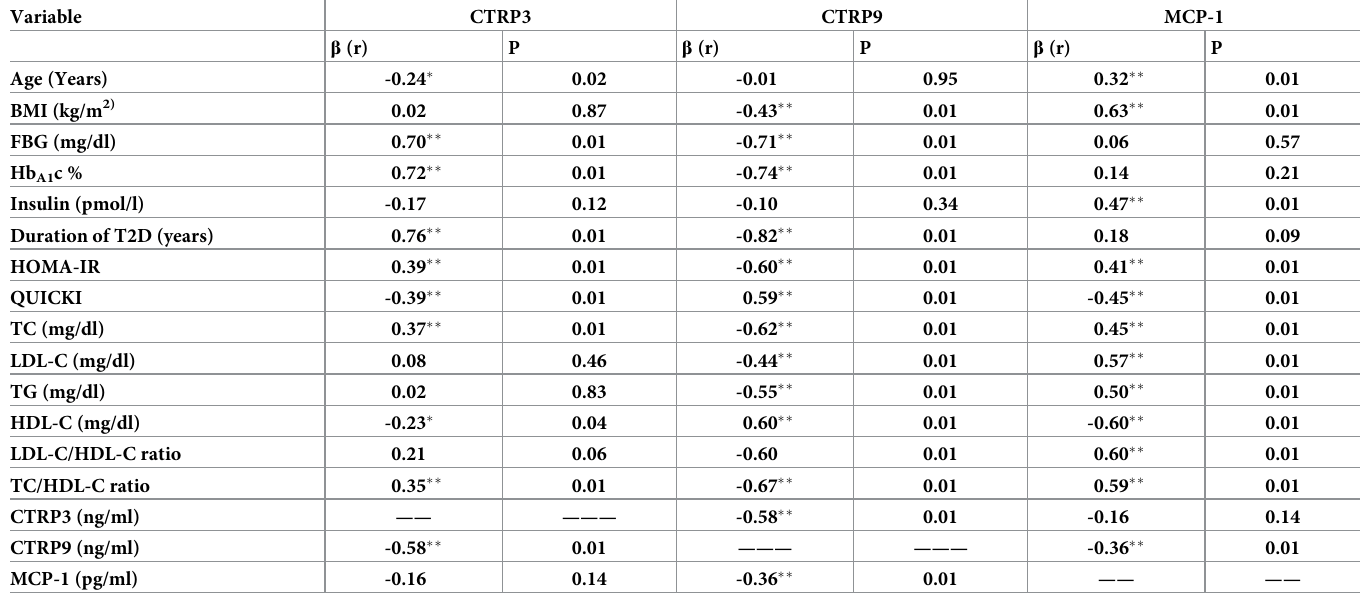
Table 2. Simple linear regression of CTRP3, CTRP9 and MCP-1 as dependant variables. Variable